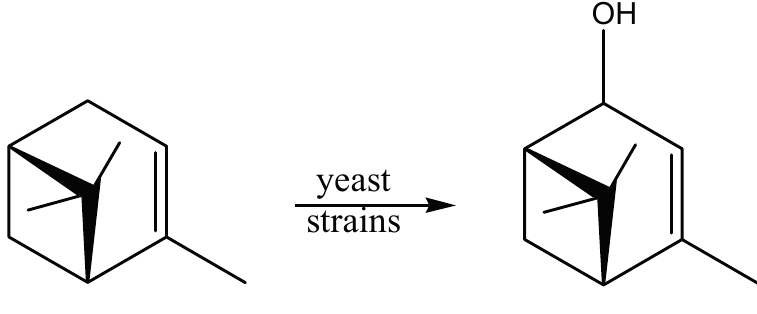
Figure 1. Biotransformation of ( − )- α -pinene to verbenol.